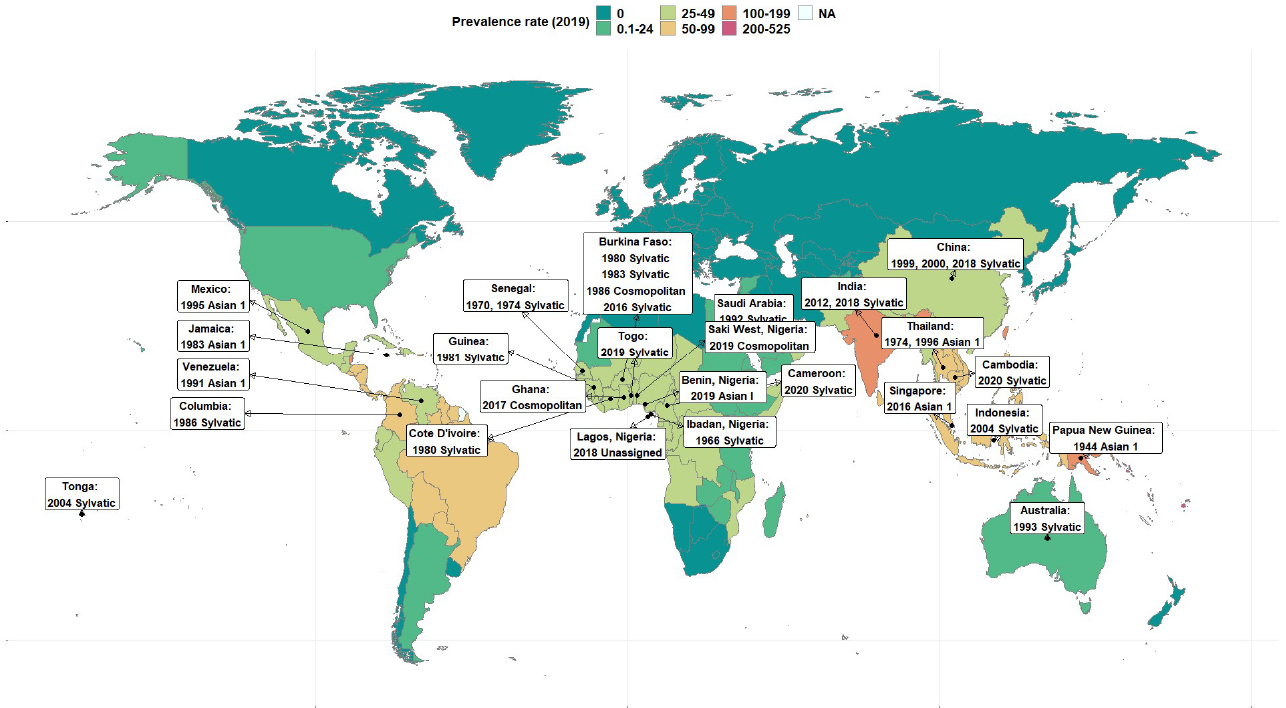
Figure 1. Map showing the global prevalence rate of dengue in 2019 and DENV-2 isolates. Source of mapped prevalence data: Global Burden of Disease Collaborative Network. Global Burden of Disease Study 2019 (GBD 2019) Results. Seattle, United States: Institute for Health Metrics and Evaluation (IHME), 2020. Available from https://vizhub.healthdata.org/gbd-results/ accessed on 13 February 2023. All rates are expressed as age-standardized based on the GBD reference population.